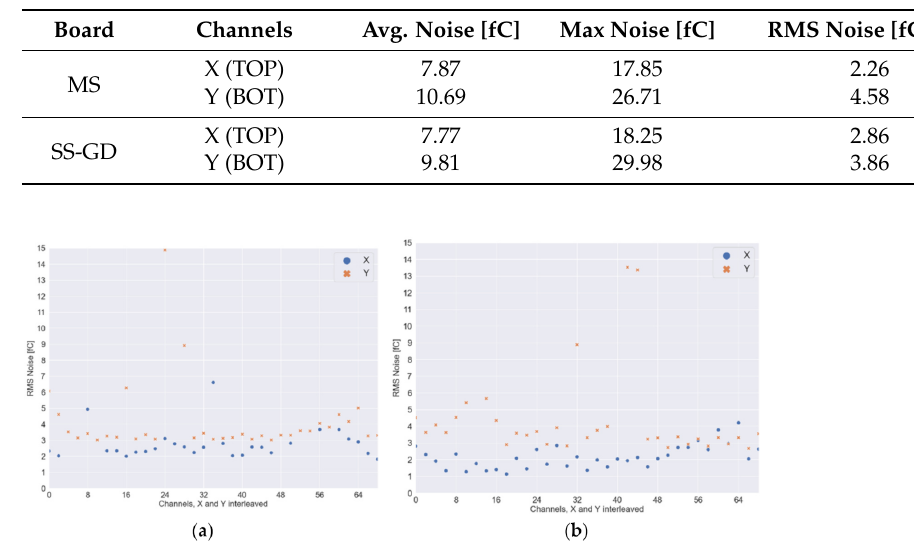
Figure 12. The RMS noise values for each channel of tested readout boards: ( a ) MS; ( b ) SS-GD readout